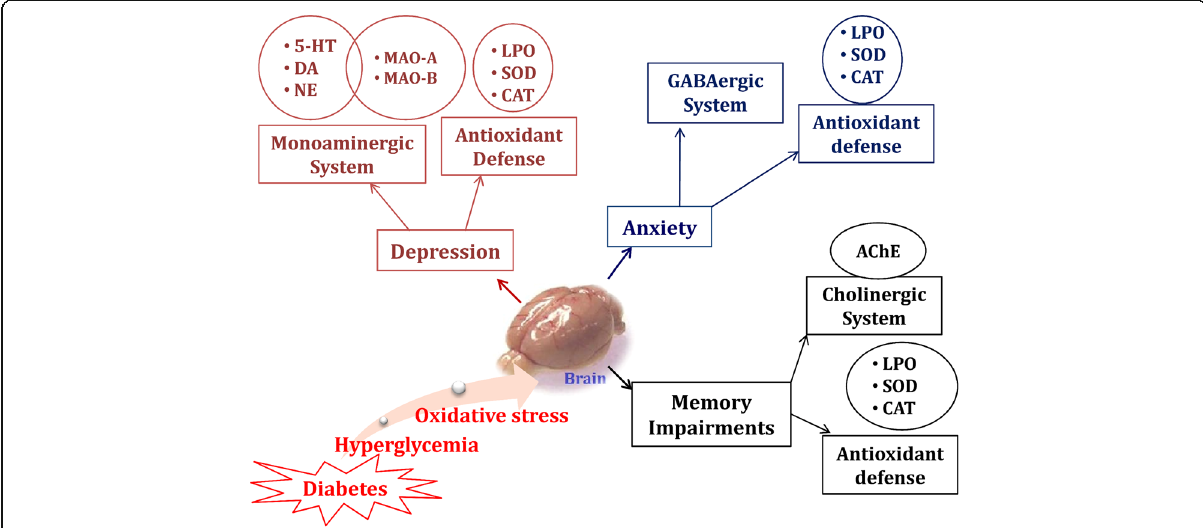
Fig. 1 Comorbid brain disorders associated with diabetes. Oxidative stress and hyperglycemia are responsible for depression, anxiety and memory impairments in diabetes. Imbalances in monoaminergic neurotransmitters and anti-oxidant system are involved in the progression of these complications. Acronyms: 5-HT: 5-Hydroxytryptamine; DA: Dopamine; NE: Nor-epinephrine; MAO-A/B: Monoamine oxidase -A/B; LPO: Lipid Hydroperoxide; SOD: Superoxide dismutase; CAT: Catalase; GABA: Gamma-aminobutyric acid; AChE: